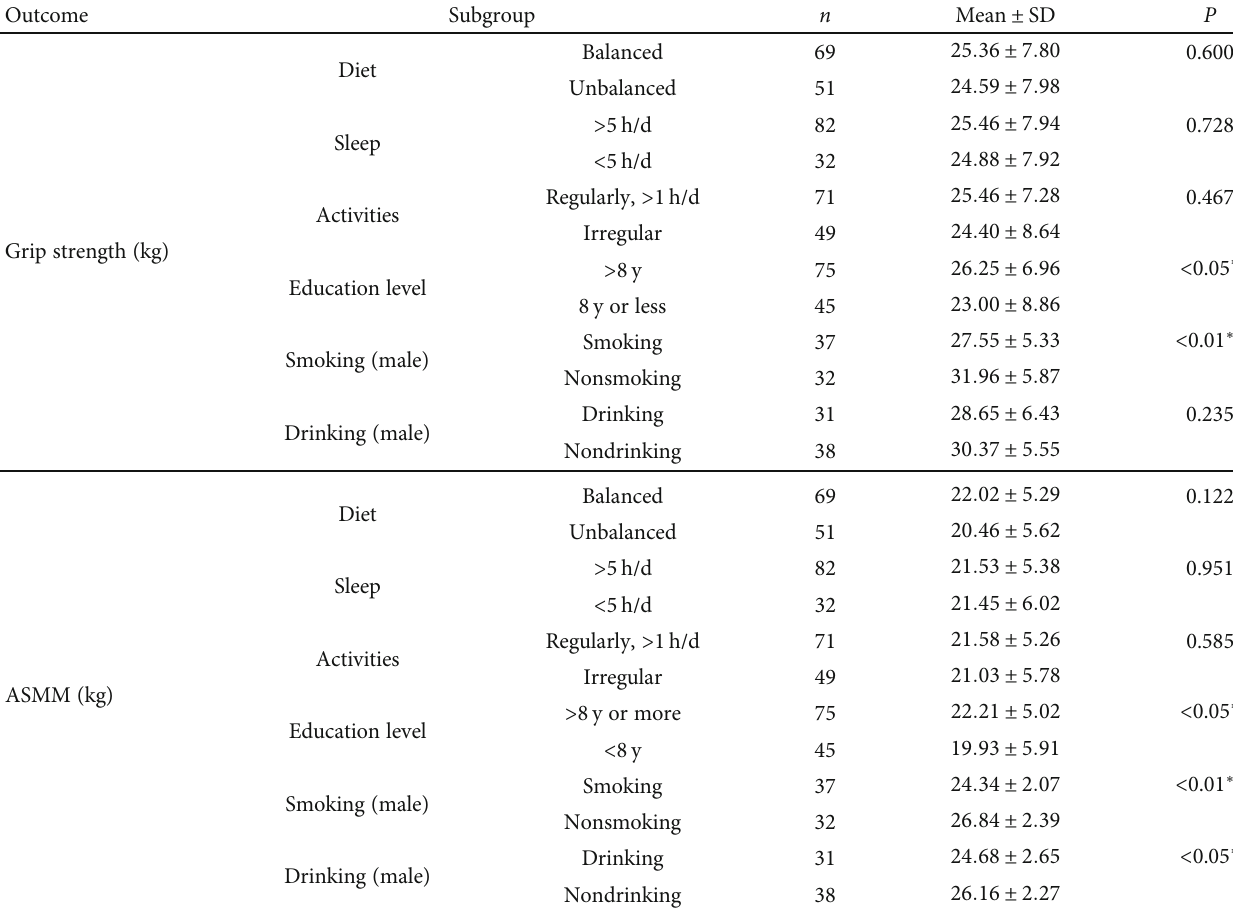
Table 3: The skeletal muscle mass and strength in T2DM patients with di ff erent